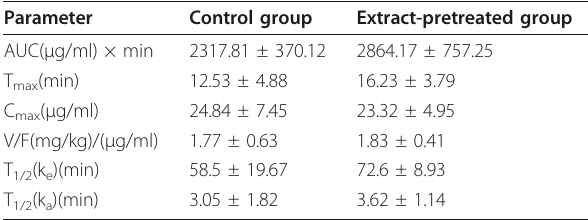
Table 2 Pharmacokinetic parameters of 5-FU (48 mg/kg) after a single i.p. injection to control rats (n = 5) or rats pretreated with TC extract (n =